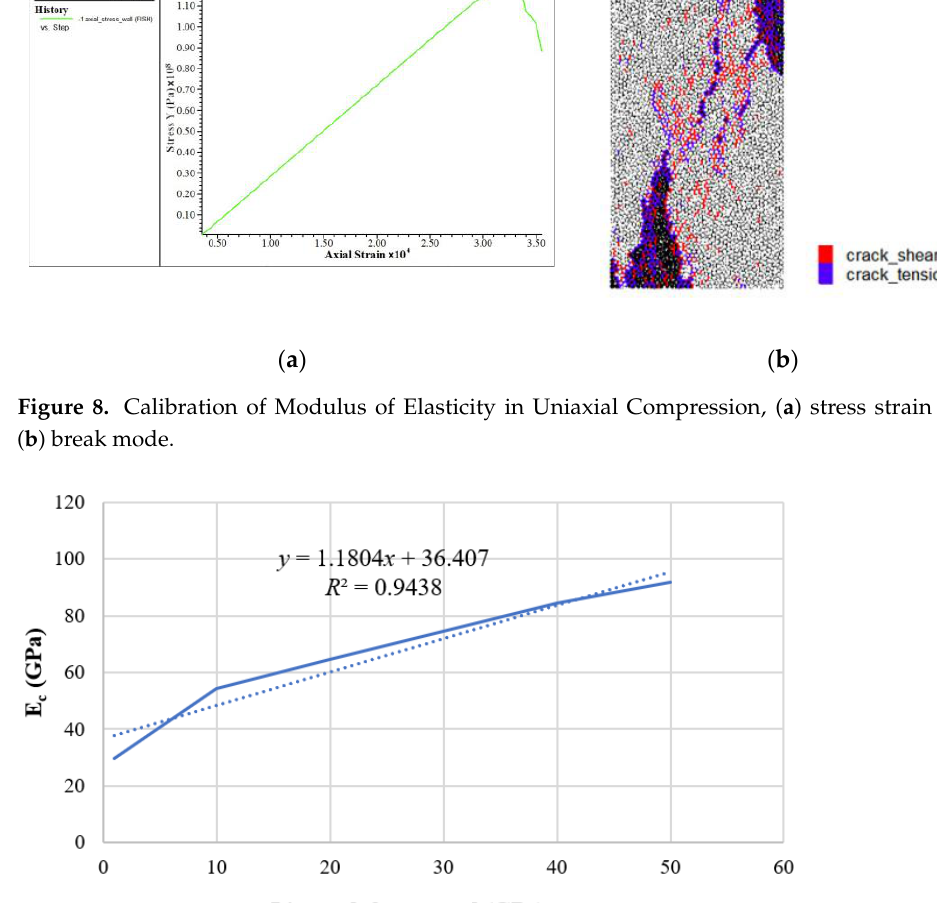
Figure 9. Relationship between compressive elastic modulus and linear contact modulus.